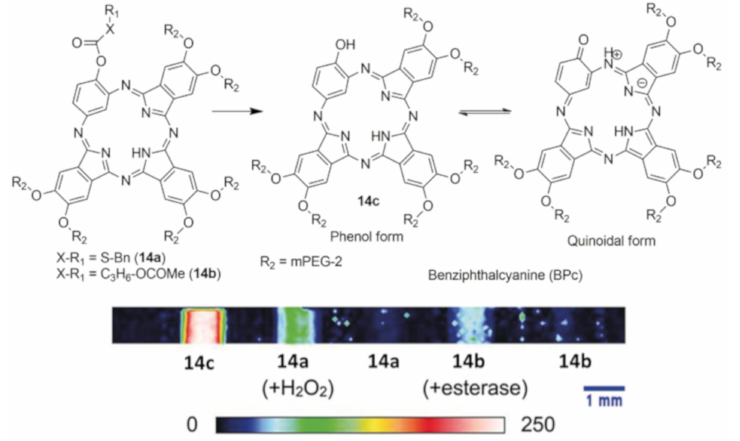
Figure 11. Top: Phthalocyanine-inspired design of benziphthalocyanine ( 14c ) chromophore, with its dynamic equilibrium of phenolic and quinoidal forms; 14a , 14b are activatable probes for detection of ROS and esterase, respectively; Bottom: PA phantom images ( λ PA = 880 nm) of 14c , and 14a , 14b with and without trigger. Reproduced from Reference [102] with permission from John Wiley and